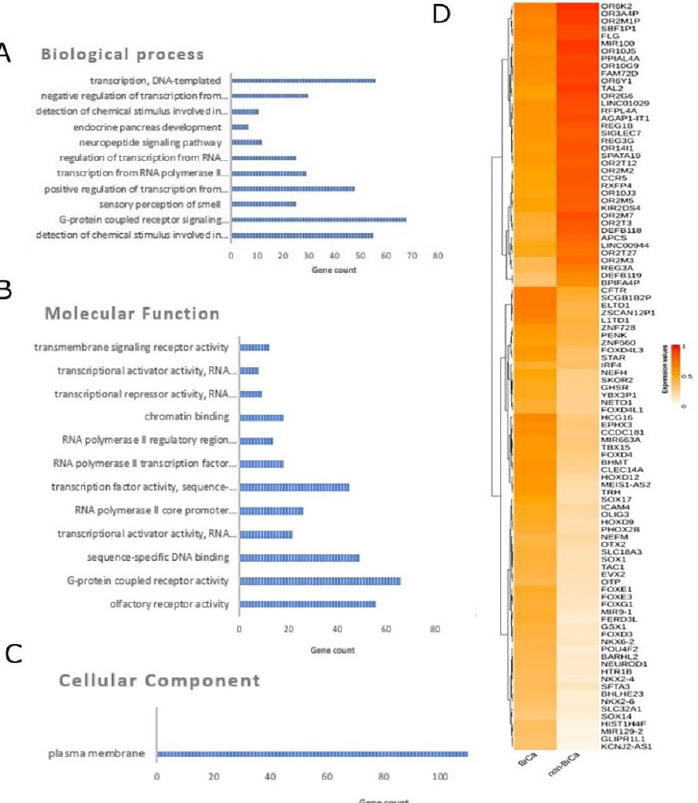
Figure 1. Differential methylation analysis comparing BrCa and healthy tissues. Gene ontology analysis of the top 400 DMGs in the aspects of ( A ) biological process, ( B ) cellular component and ( C ) molecular function analysis. ( D ) Heatmap plot of top 100 DMGs comparing BrCa and healthy tissues. Abbreviations: BrCa = breast cancer, DMGs = differentially methylated genes.